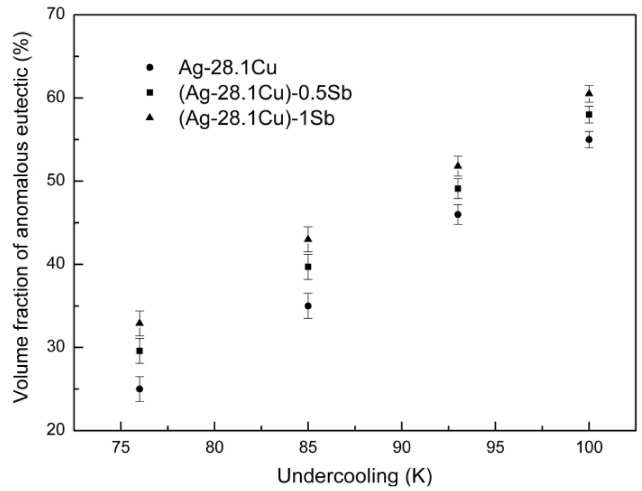
Figure 7. Volume fraction of anomalous eutectic versus undercooling for different Sb contents.